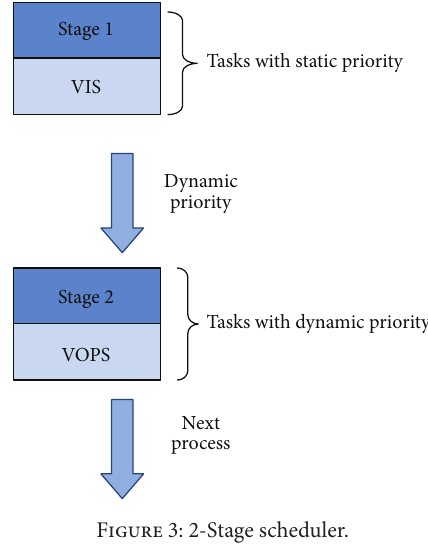
Figure 3: 2-Stage